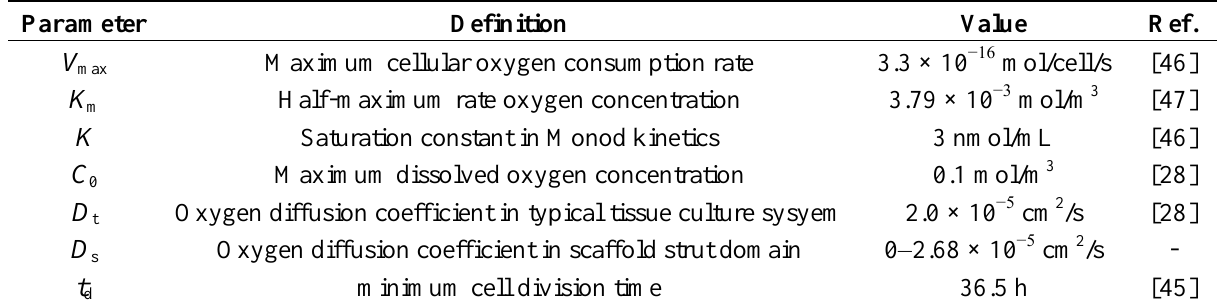
Table 1. Parameter values and